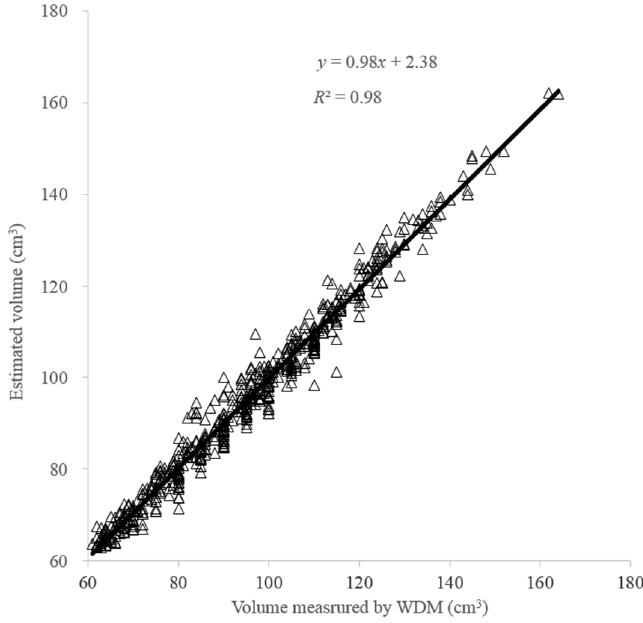
Figure 7. Comparison of fruit volume between estimation and measurement by water displacement method (WDM) in the validation dataset.